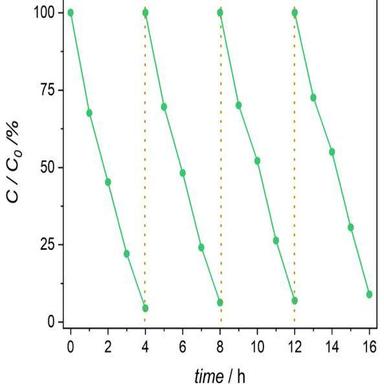
The four cycles of photocatalytic degradation of styrene using Bi/g-C3N4 catalyst.